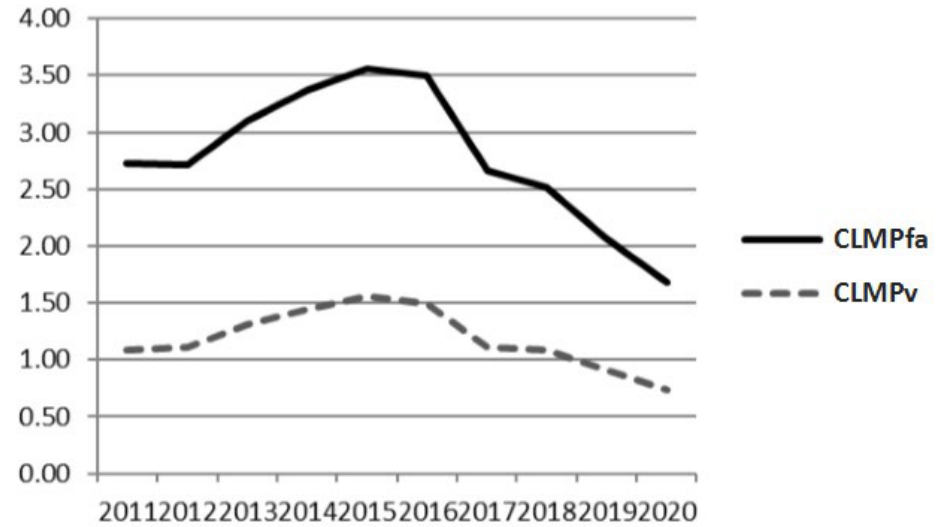
Figure 7. CLMP value dynamic for the PJSC “Norilsk Nickel”. CLMPfa—CLMP based on total fixed assets; CLMPv—CLMP based on total cost of machinery and equipment.